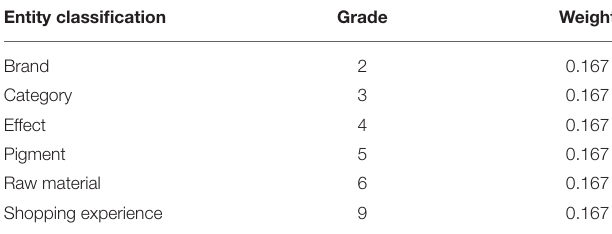
TABLE 2 | Cosmetic class weight system b.